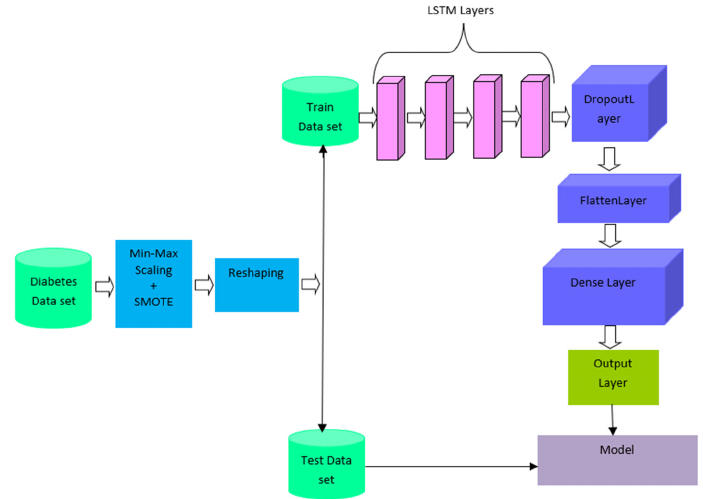
Figure 1. SMOTE-based deep LSTM for diabetic prediction. Table 2. Layer-wise training detail of SMOTE-based deep LSTM model.